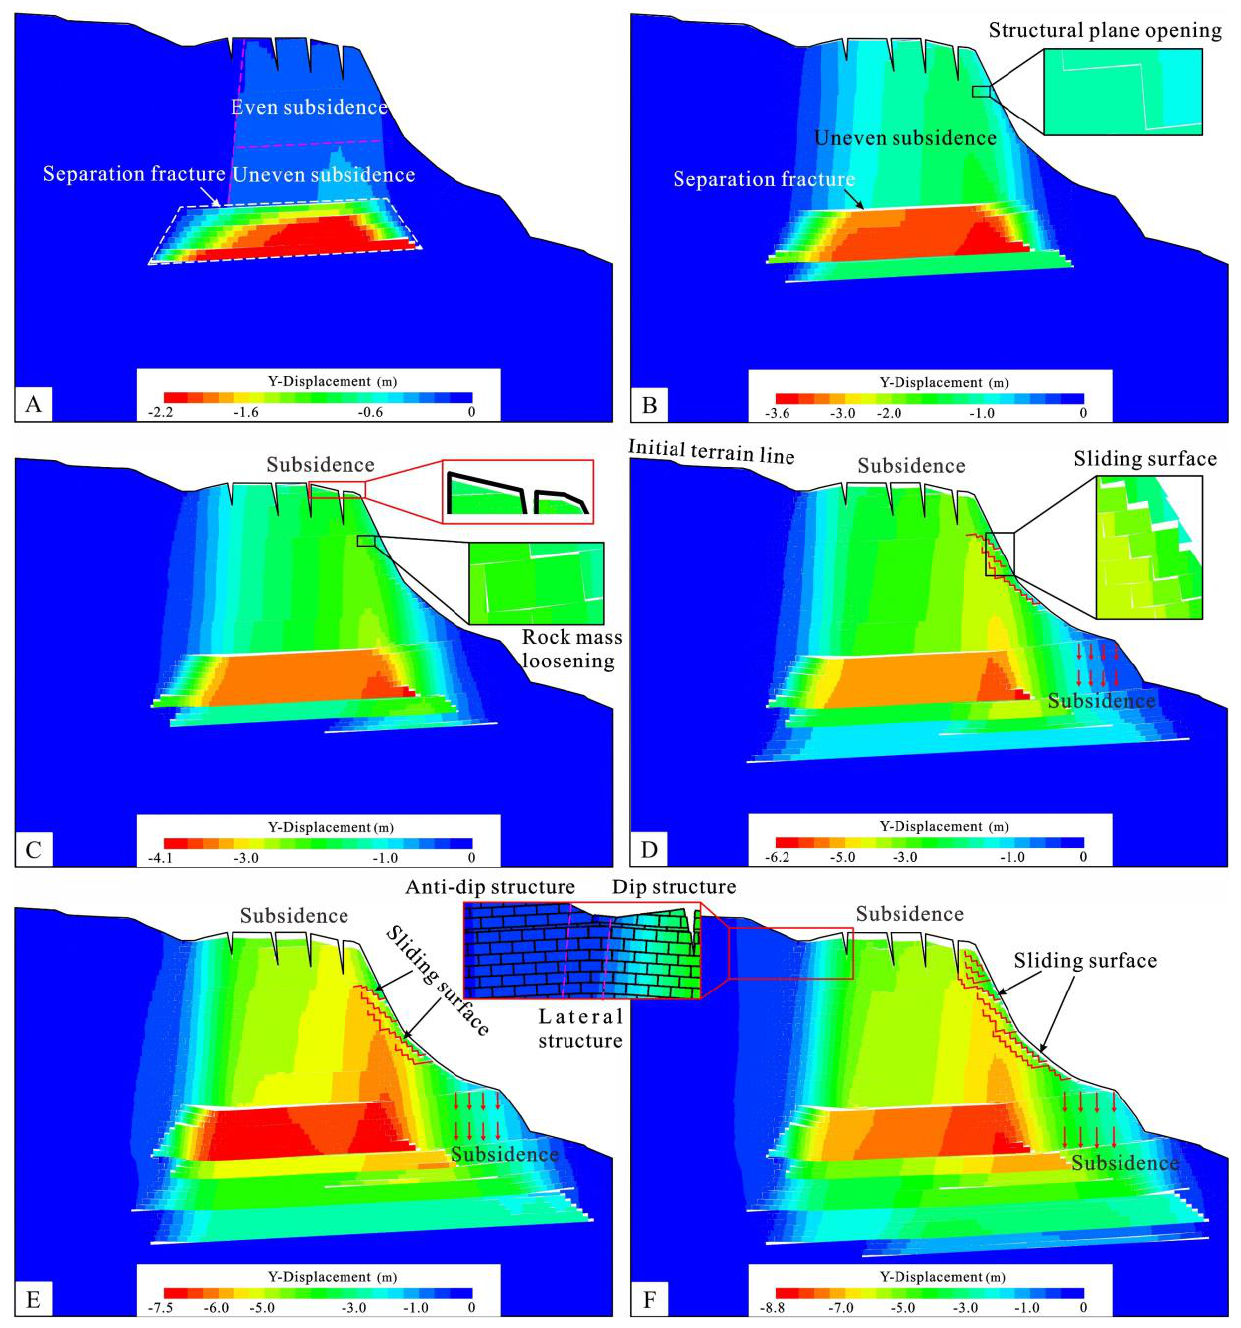
Figure 20. Evolution of vertical displacement under underground mining conditions: ( A ) mining stages I − II; ( B ) mining stages I − IV; ( C ) mining stages I − VI; ( D ) mining stages I − VIII; ( E ) mining stages I − X; and ( F ) mining stages I − XII. Note: the negative values indicate vertical downward displacement.